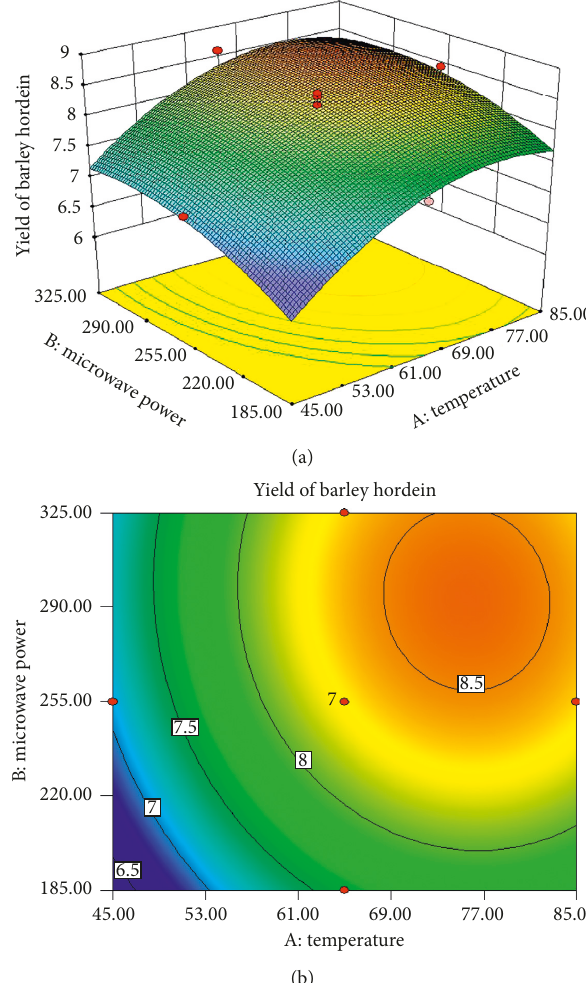
Figure 2: Response surface plot and contour plot showing the effect of temperature and microwave power on the yield of barley hordein at ultrasonic power 640W and extraction time